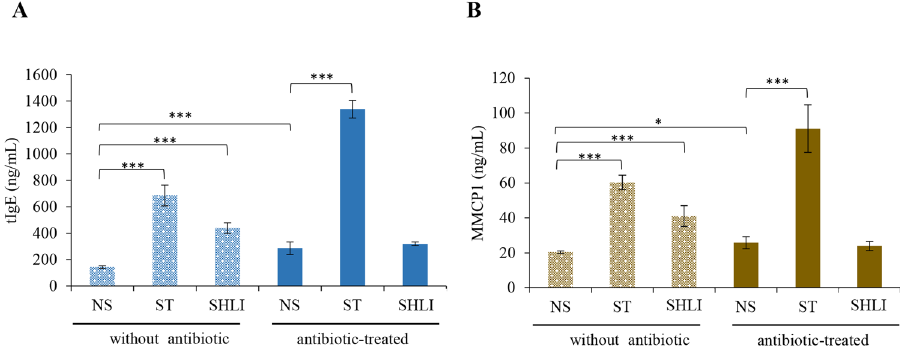
Figure 2. SHLI fails to elevate serum tIgE ( A ) and MMCP1 ( B ) levels in antibiotic-treated mice (n = 8). We fed mice autoclaved water with or without ampicillin (0.5 mg/mL), gentamicin (0.5 mg/mL), metronidazole (0.5 mg/mL), neomycin (0.5 mg/mL), and vancomycin (0.25 mg/mL) continuously via a water bottle. In the event of poor animal hydration, we supplemented control and antibiotic water with artificial sweetener. Five weeks later, the mice were sacrificed, and the serum tIgE and MMCP1 levels were measured by ELISA. * P < 0.05 and *** P < 0.001.